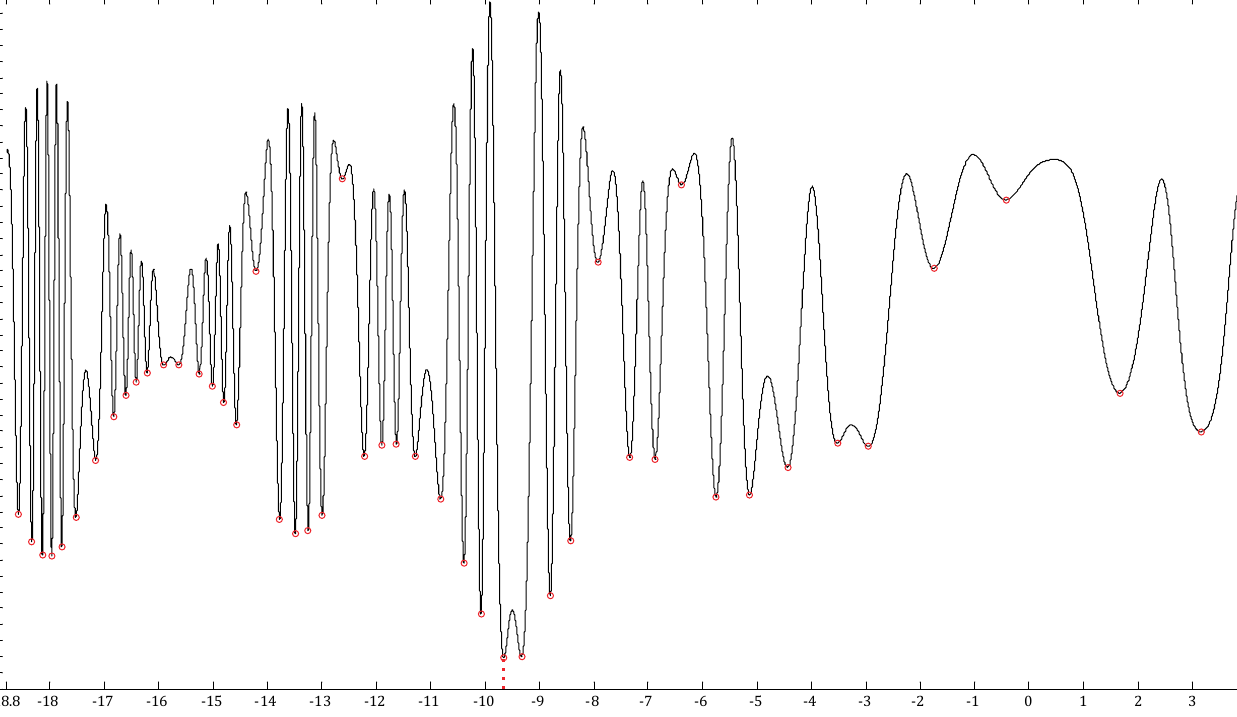
Fig. 7. The 48 local minima, including only the local right boundary minima and the global minimum (marked by the dotted line downward) of function (44) on interval [ − 18.8; 4].